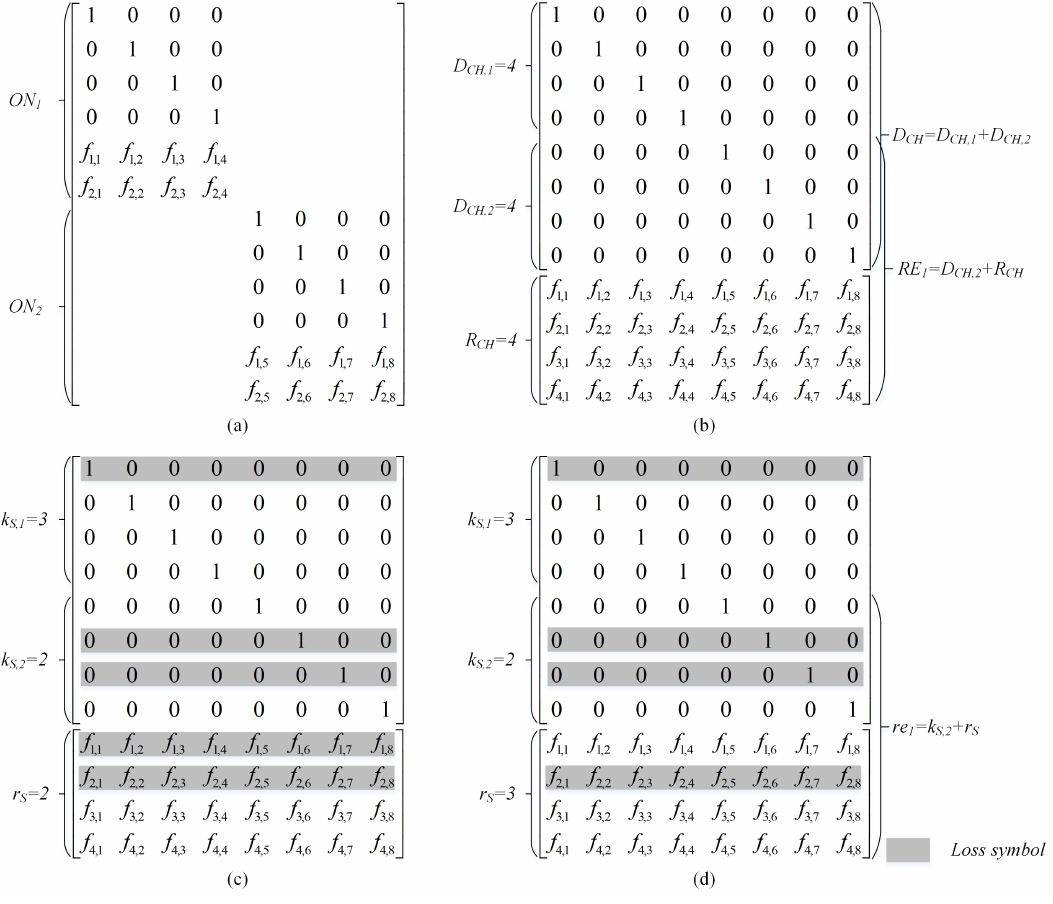
Figure 6. Representative matrix of coefficient coding information at CH and sink; ( a ) SNC; ( b ) DSNC; ( c ) case of D S ,1 = 3 ≤ D CH ,1 ; ( d ) case of D S ,1 = D CH ,1 = 4 or M S =